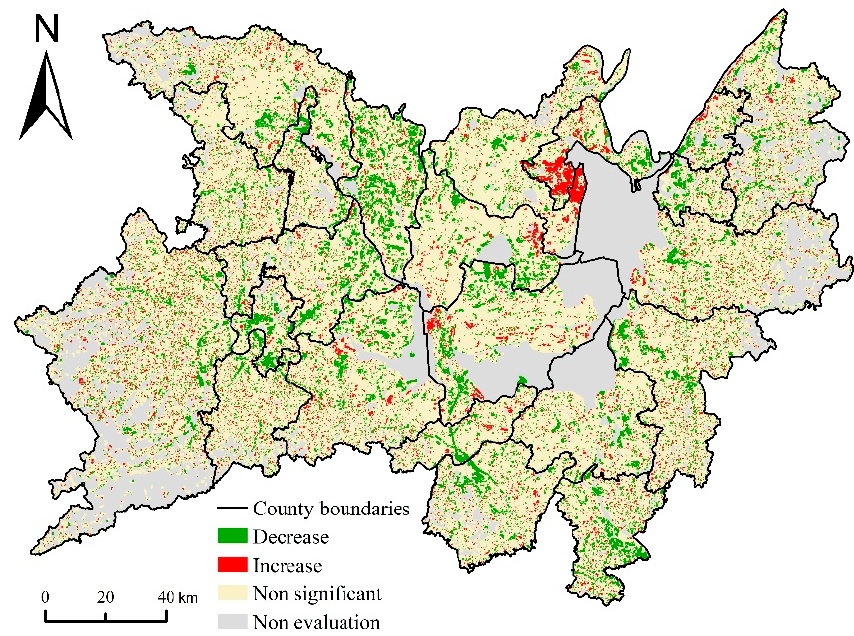
Figure 6. Trend analysis of increase and decrease